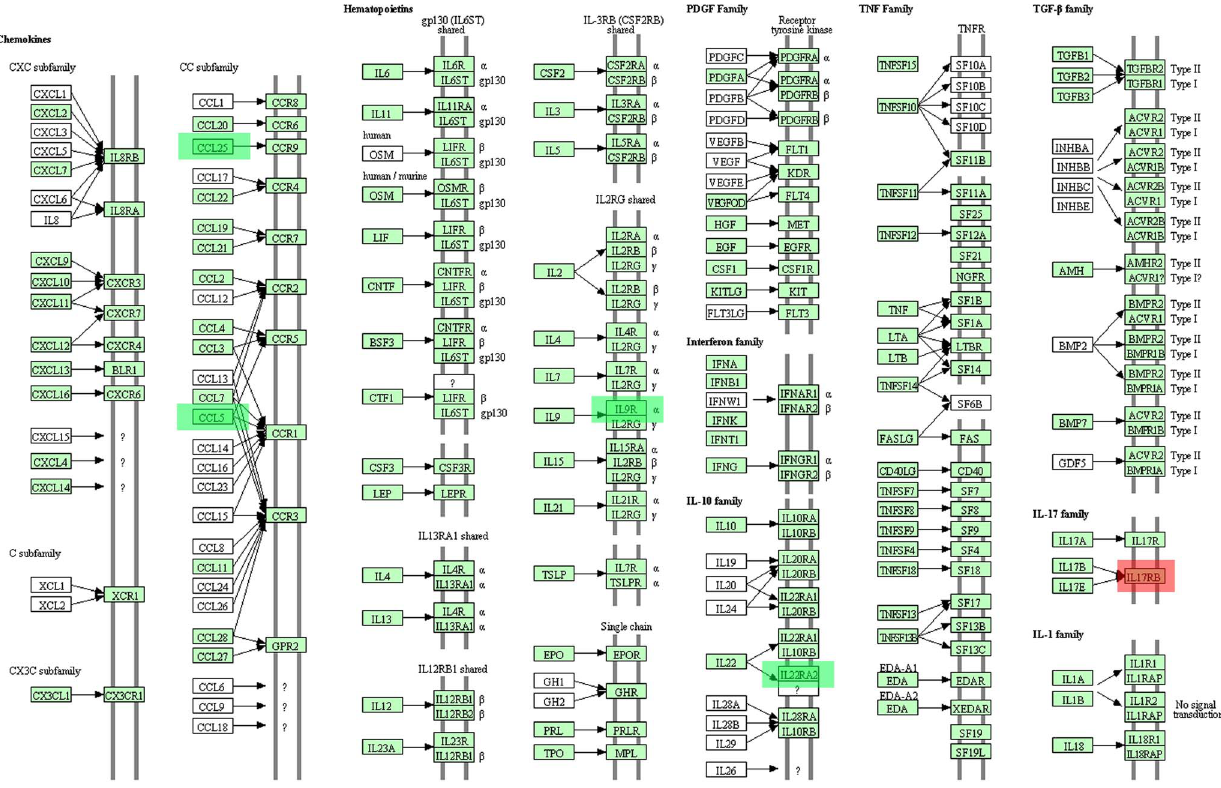
Figure 2. Cytokine-cytokine receptor interaction signaling pathway. The most significant inhibition of cell factor – cell factor receptor interaction path diagram of the 21- day stress group compared with the normal group. The green label for the channel of down-regulate genes: IL22RA2, IL9R, CCL5, CCL25. The red label for the path of the up-regulate gene: IL17RB.